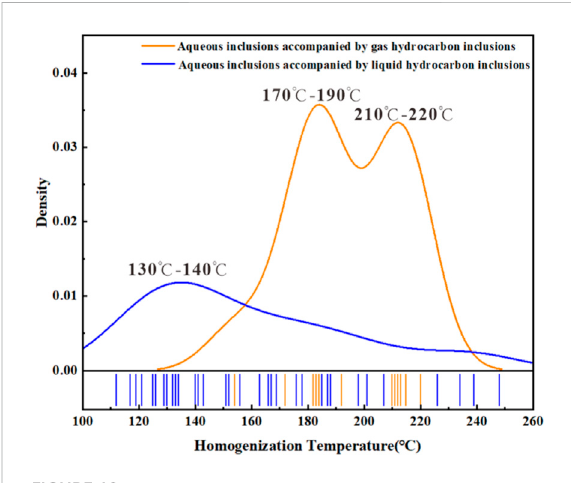
FIGURE 10 An illustration of the homogenization temperature of two- phasegas-liquid brineinclusionsfoundintheDengying reservoirs, Well PT1, and the Penglai Block of the North